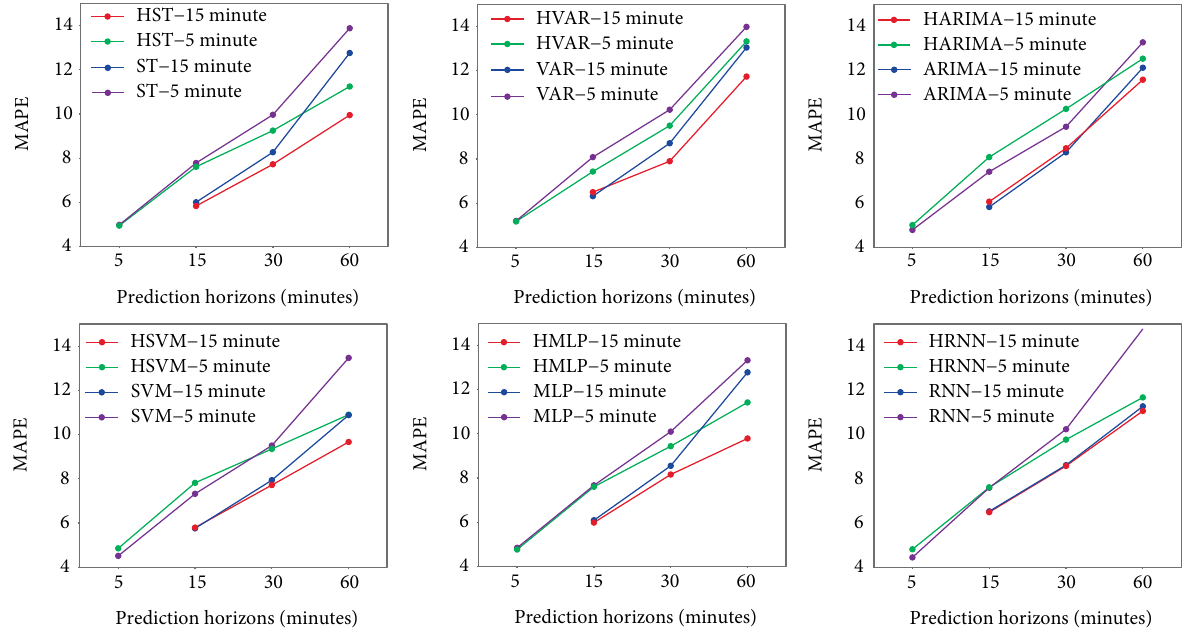
Figure 10: The MAPE values of models for different horizons and aggregation levels in off-peak hours on station